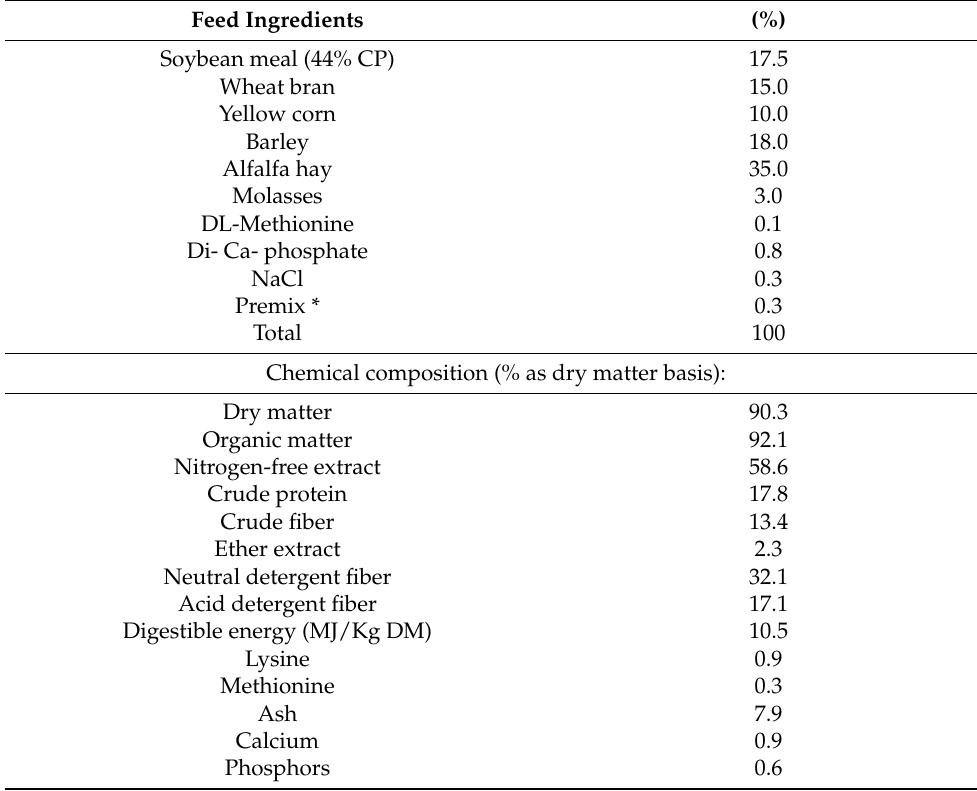
Table 1. Ingredients and chemical composition of the experimental diet (% as dry matter